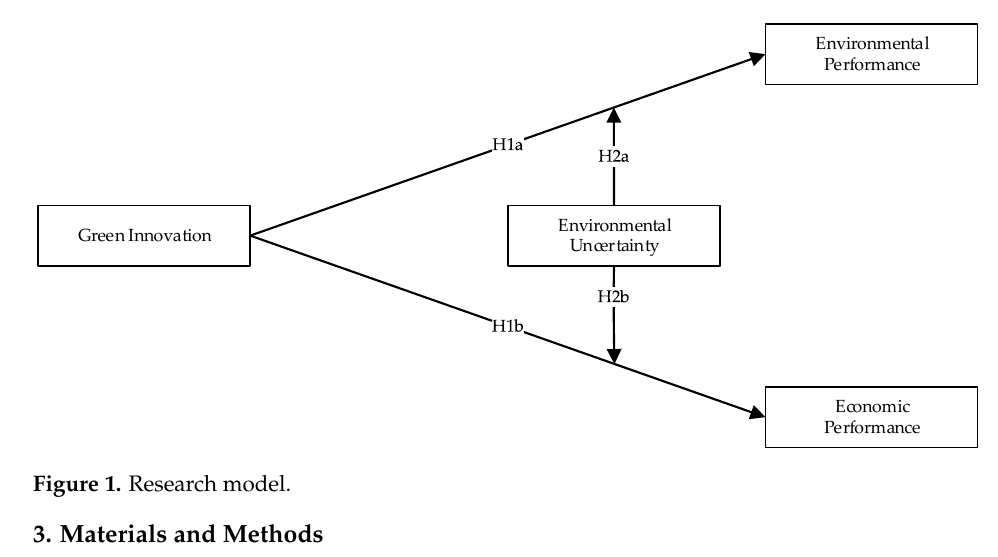
Figure 1. Research